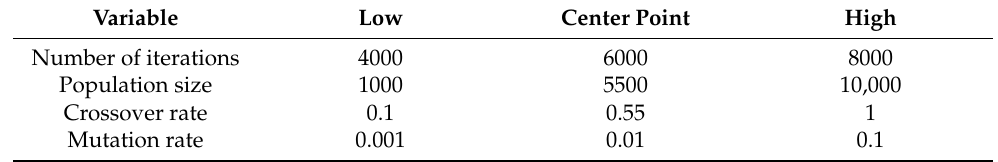
Table 2. Variable analyzed by means of design of experiments (DOE) methodology and values considered. Variable Low Center Point High Number of iterations 4000 6000 8000 Population size 1000 5500 10,000 Crossover rate 0.1 0.55 1 Mutation rate 0.001 0.01